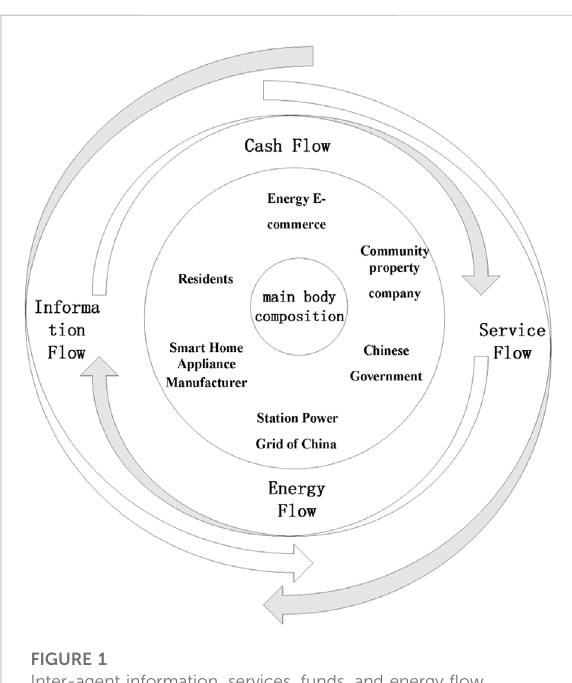
FIGURE 1 Inter-agent information, services, funds, and energy fl ow